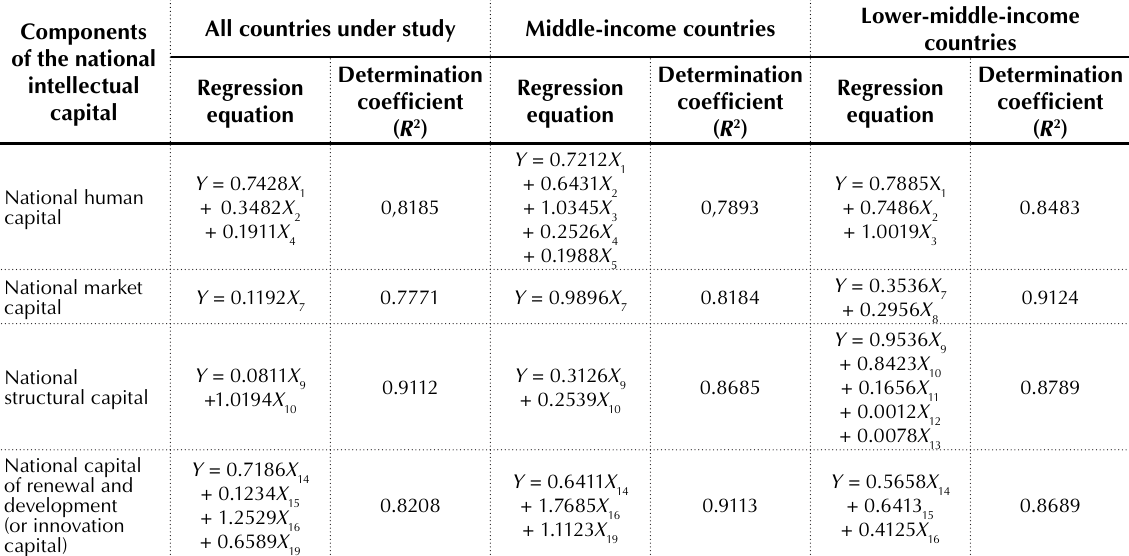
Table 4. Relationship between the dynamics of economic growth and the national intellectual capital components in the Central and Eastern European post-socialist countries